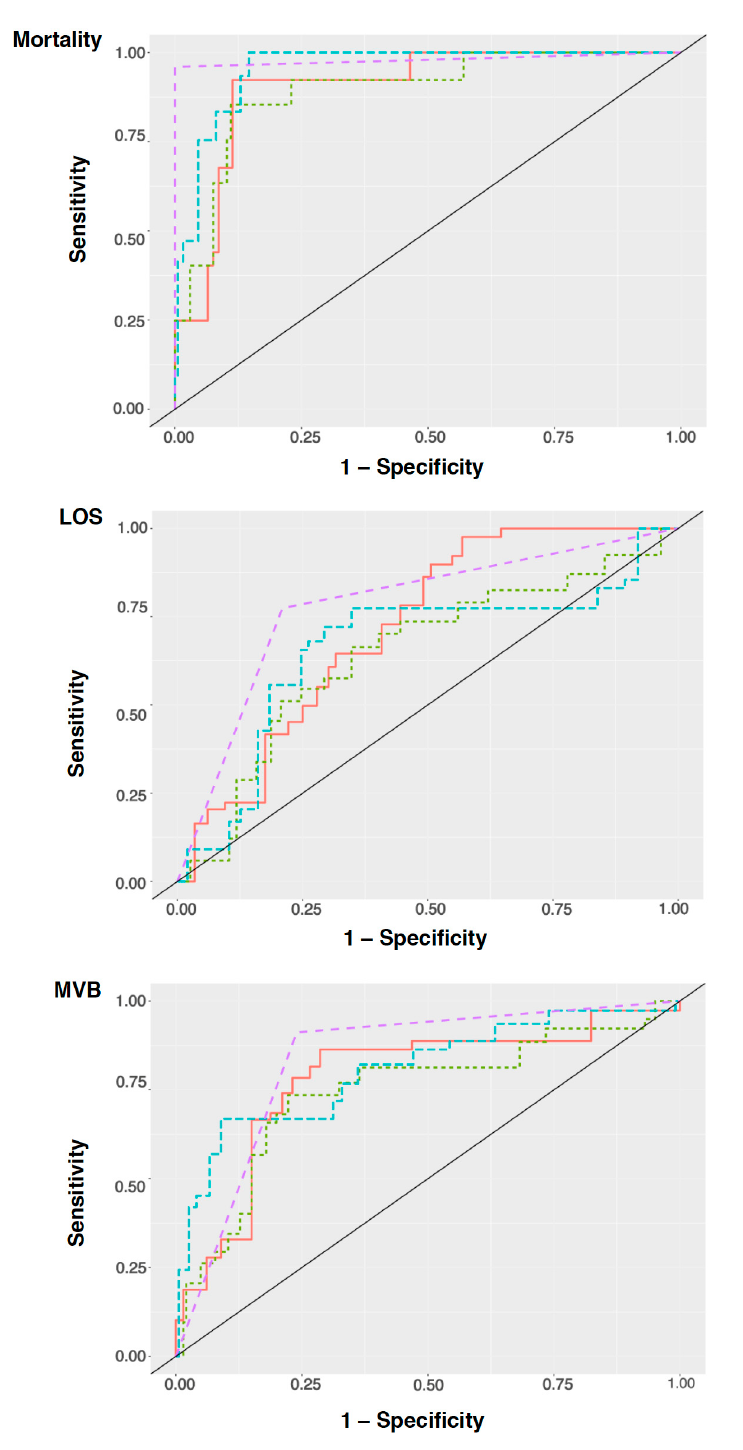
Figure 1. Area under the curve for mortality ( top ), LOS ( middle ); and MV ( bottom ); Algorithm colors–Purple: XGBoost, red: logistic classifier, Green: naïve Bayes, blue: random forest.; LOS: length of stay, MV: need for mechanical ventilation.